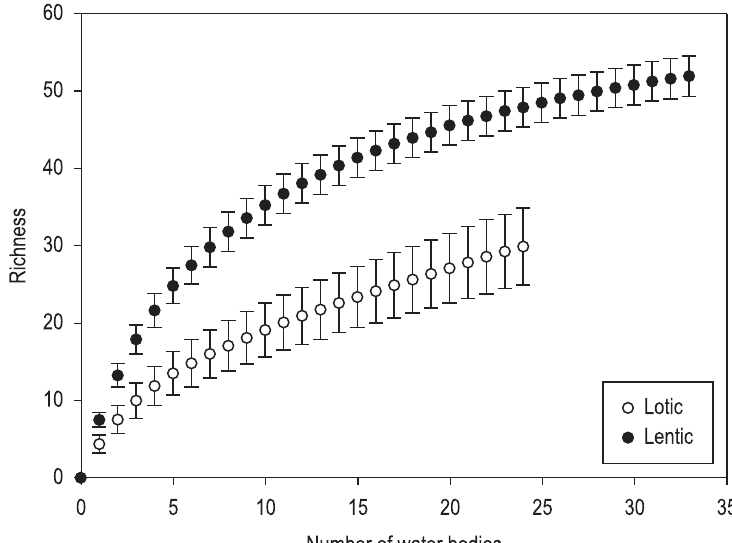
Figure 2. Comparison of the richness of cladocerans between lentic and lotic water bodies using rarefaction